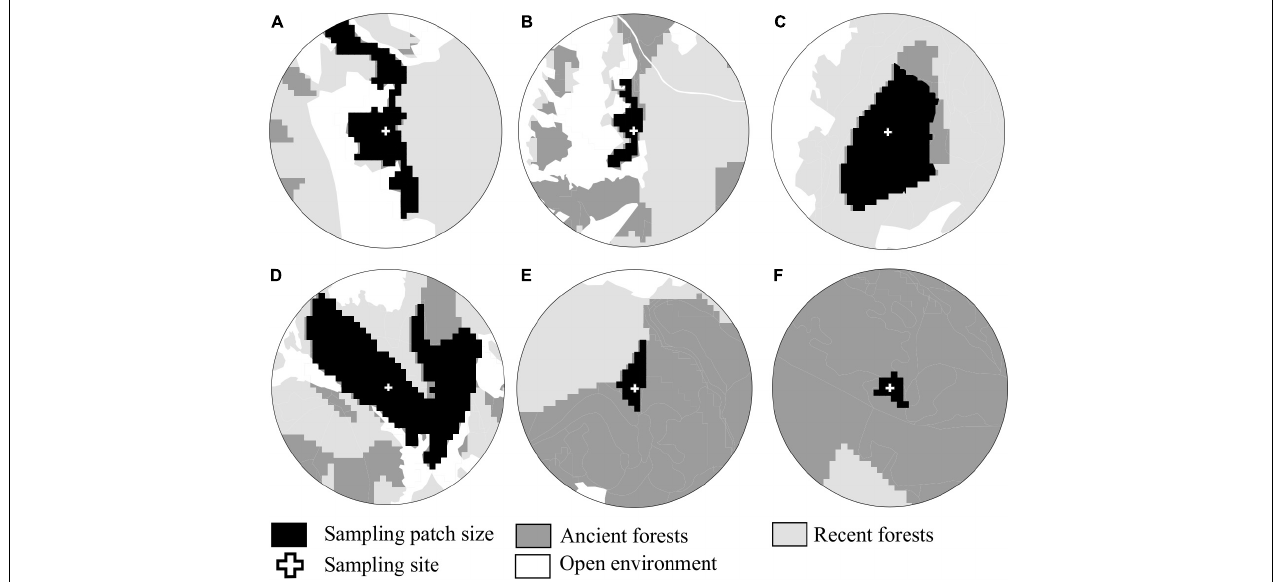
FIGURE 2 | Examples of landscape structure, illustrating gradients of habitat amount in the landscape, from (A) a landscape dominated by recent forest, to (F) a landscape dominated by ancient forest. The size of the central patch can be variable, and does not correlate with the quantity of ancient forest in the buffer. As an example, both large (A–C) and small patches (B,E,F) of ancient forests were sampled, in landscapes with a variable quantity of ancient forests (increasing from (A–F)